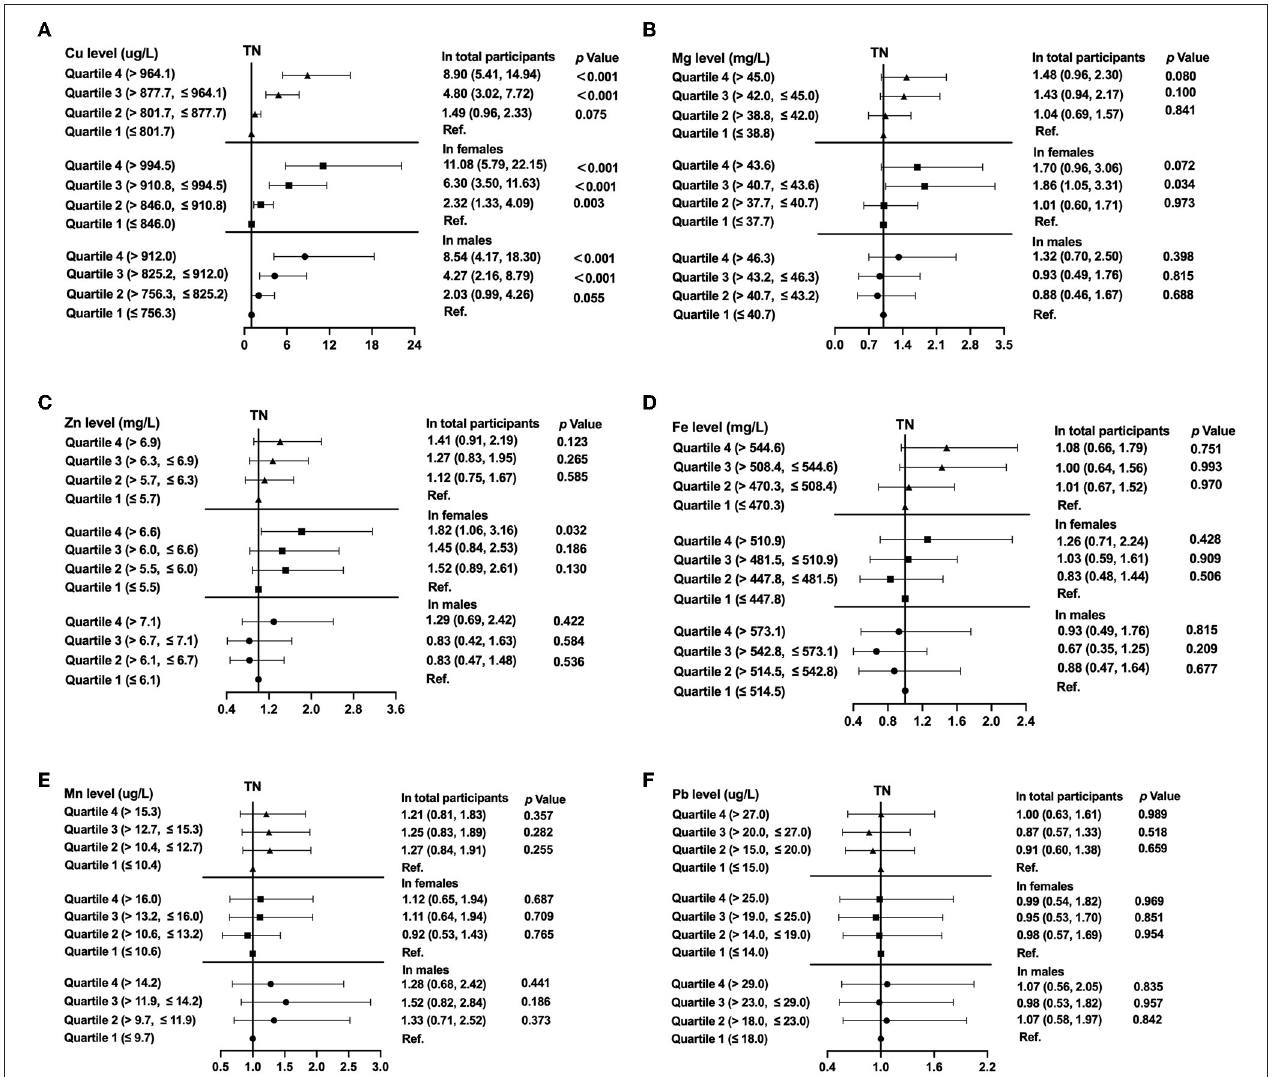
FIGURE 4 | The prevalence of thyroid nodules (TNs) by quartiles of trace element levels, showing odds ratios for Copper (A) , Magnesium (B) , Zinc (C) , Iron (D) , Manganese (E) , Lead (F) . In the total population, the model was adjusted for model 2. In stratified analysis by sex, the model was adjusted for age, UIE, BMI, smoking status, excessive alcohol consumption, HbA1c, TC, TG, and